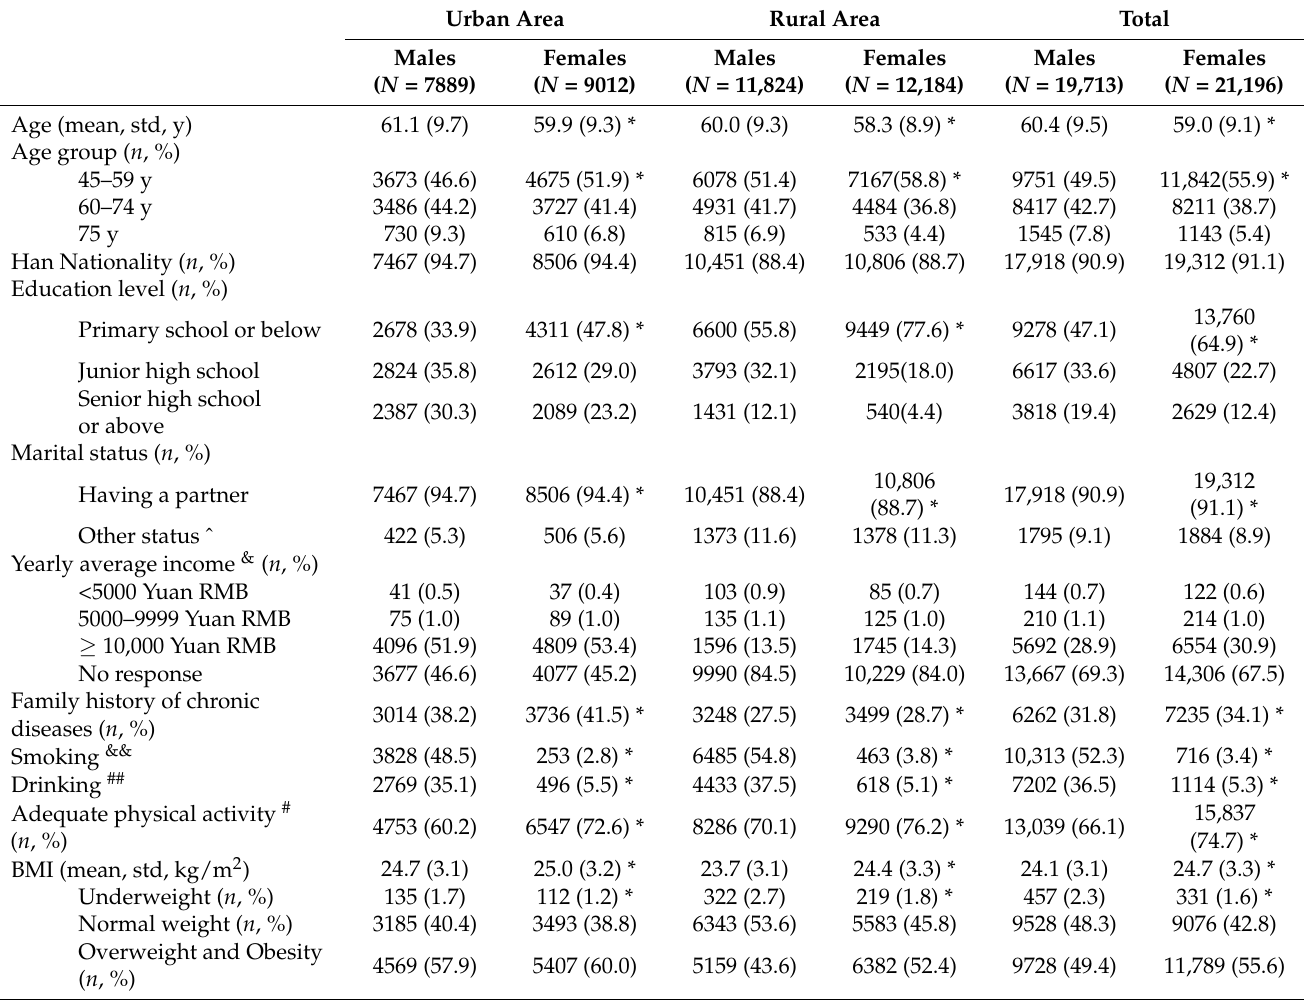
Table 1. General information and life style of the participants aged 45 y and above in the survey. Urban Area Rural Area